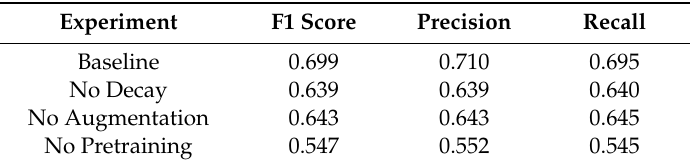
Table 2. Training with di ff erent